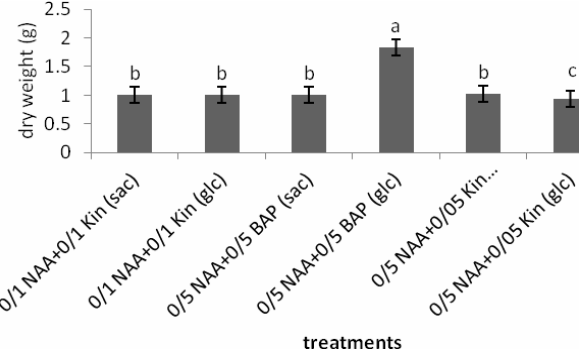
Fig. 7. The effect of explant on callus, shoot and root induction of A. annua ; Duncan’s multiple range test at 0.1% probability